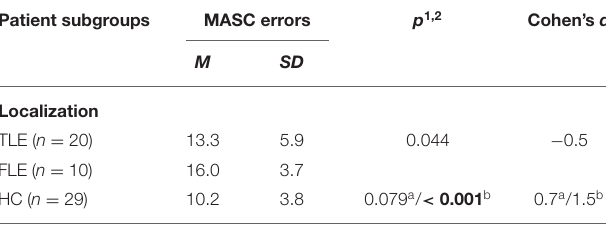
TABLE 4 | ToM performance according to group status (epileptogenic focus, control